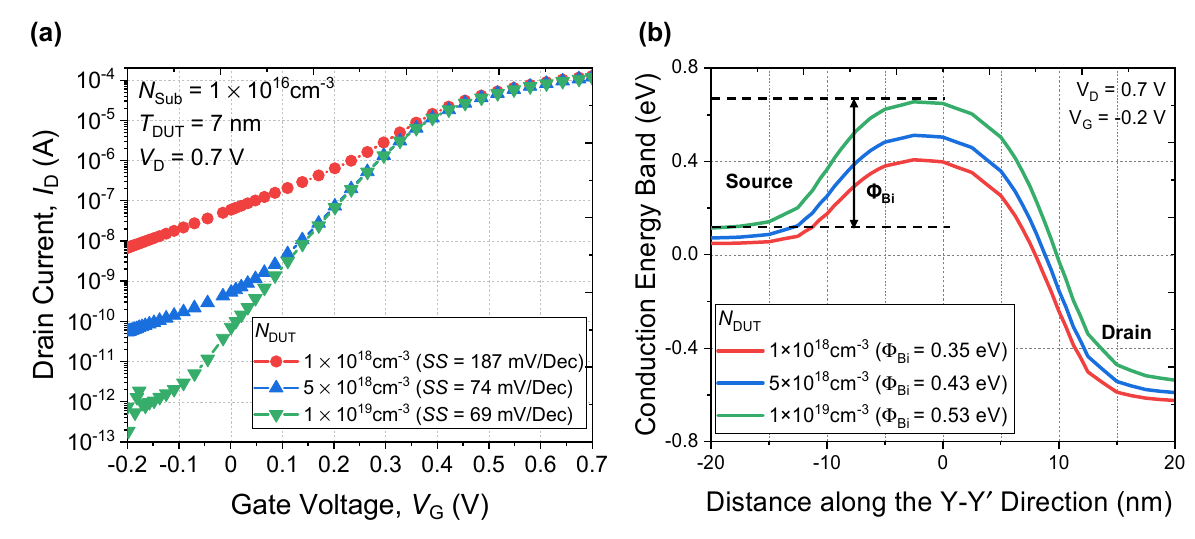
Figure 7. ( a ) I D – V G characteristic with different N DUT layer. ( b ) Energy band diagram of the parasitic channel.